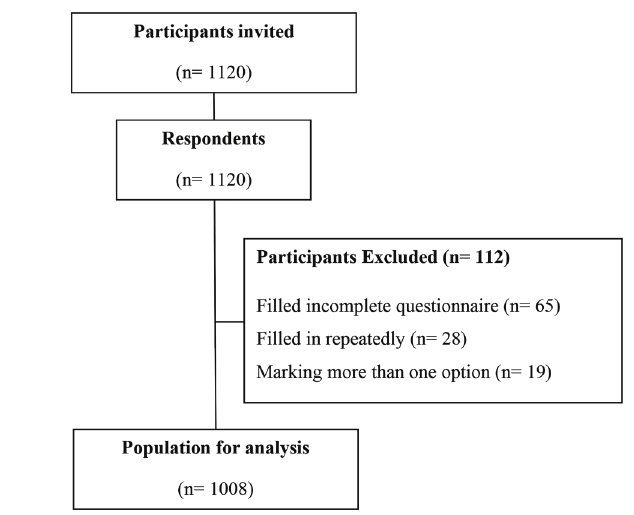
Figure 1 - Flow-chart of study